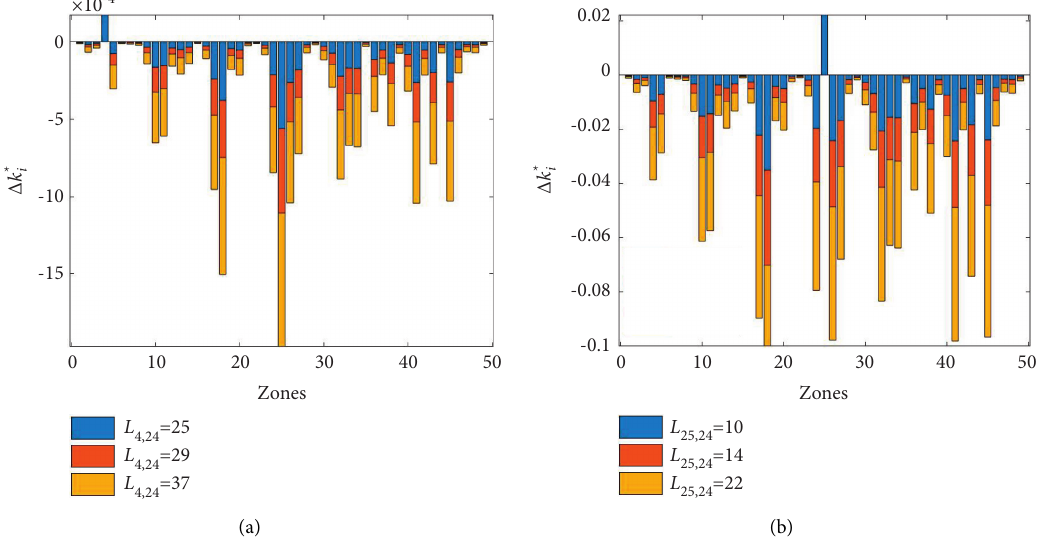
Figure 11: The change of k ∗